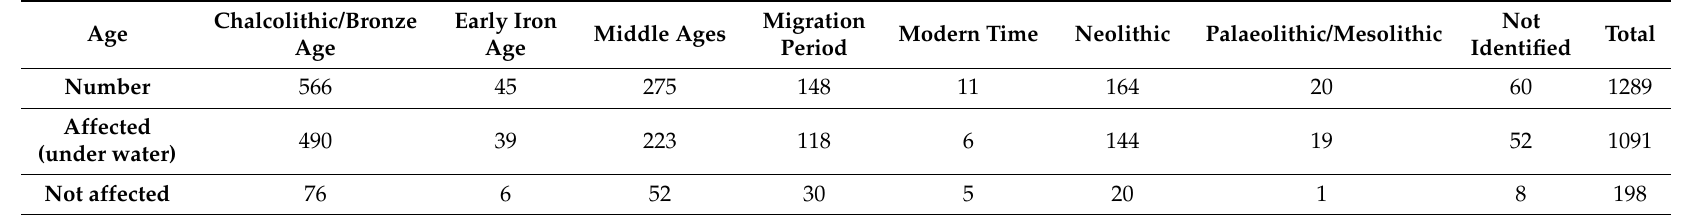
Table 3. Distribution of cultural heritage sites around Kuibyshev reservoir according to their